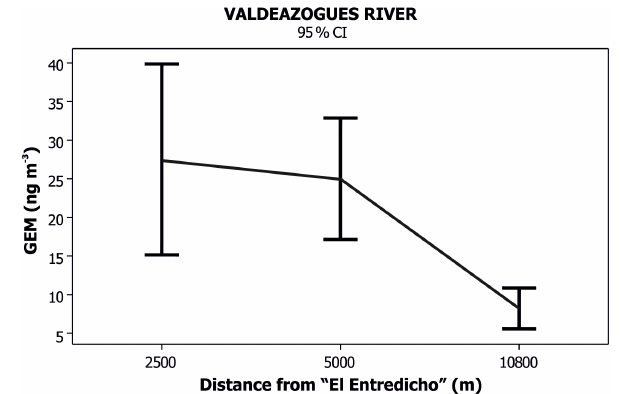
Figure 6. Variability in GEM levels on cross-cuts of the Valdea- zogues River according to distance from the El Entredicho